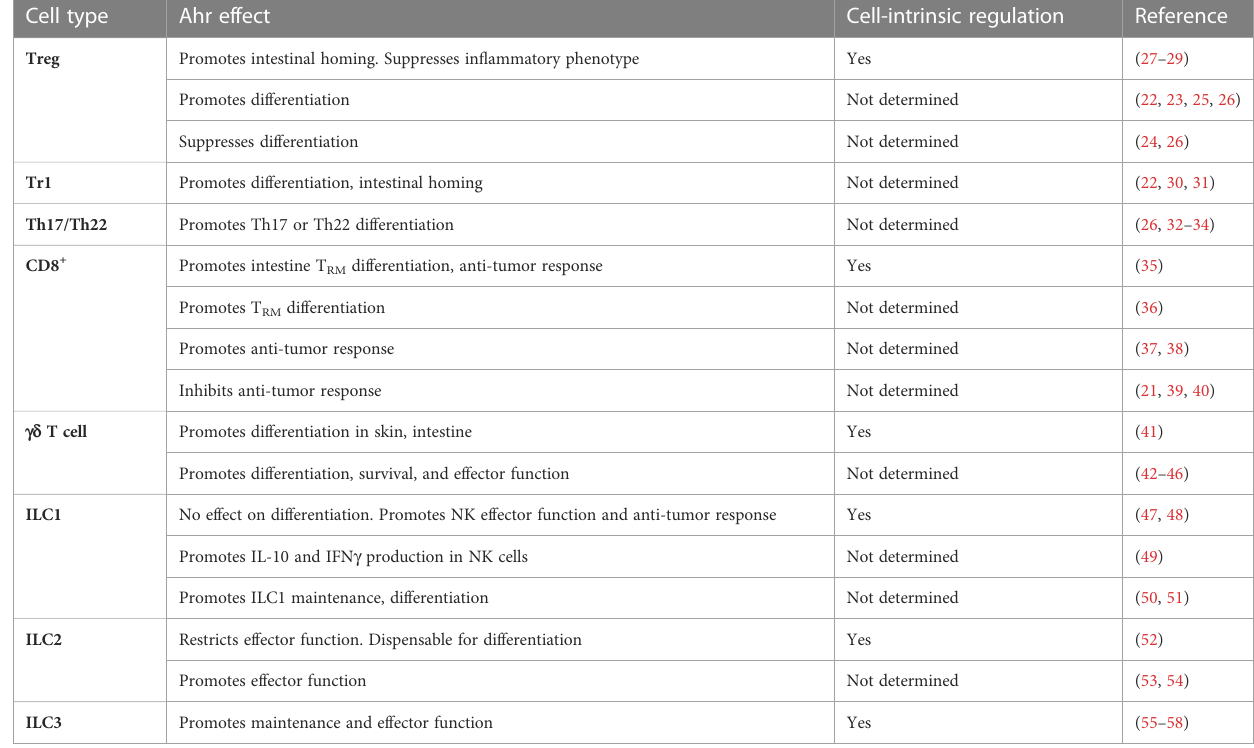
TABLE 1 Cell type speci fi c, cell intrinsic effects of Ahr in ILCs and T